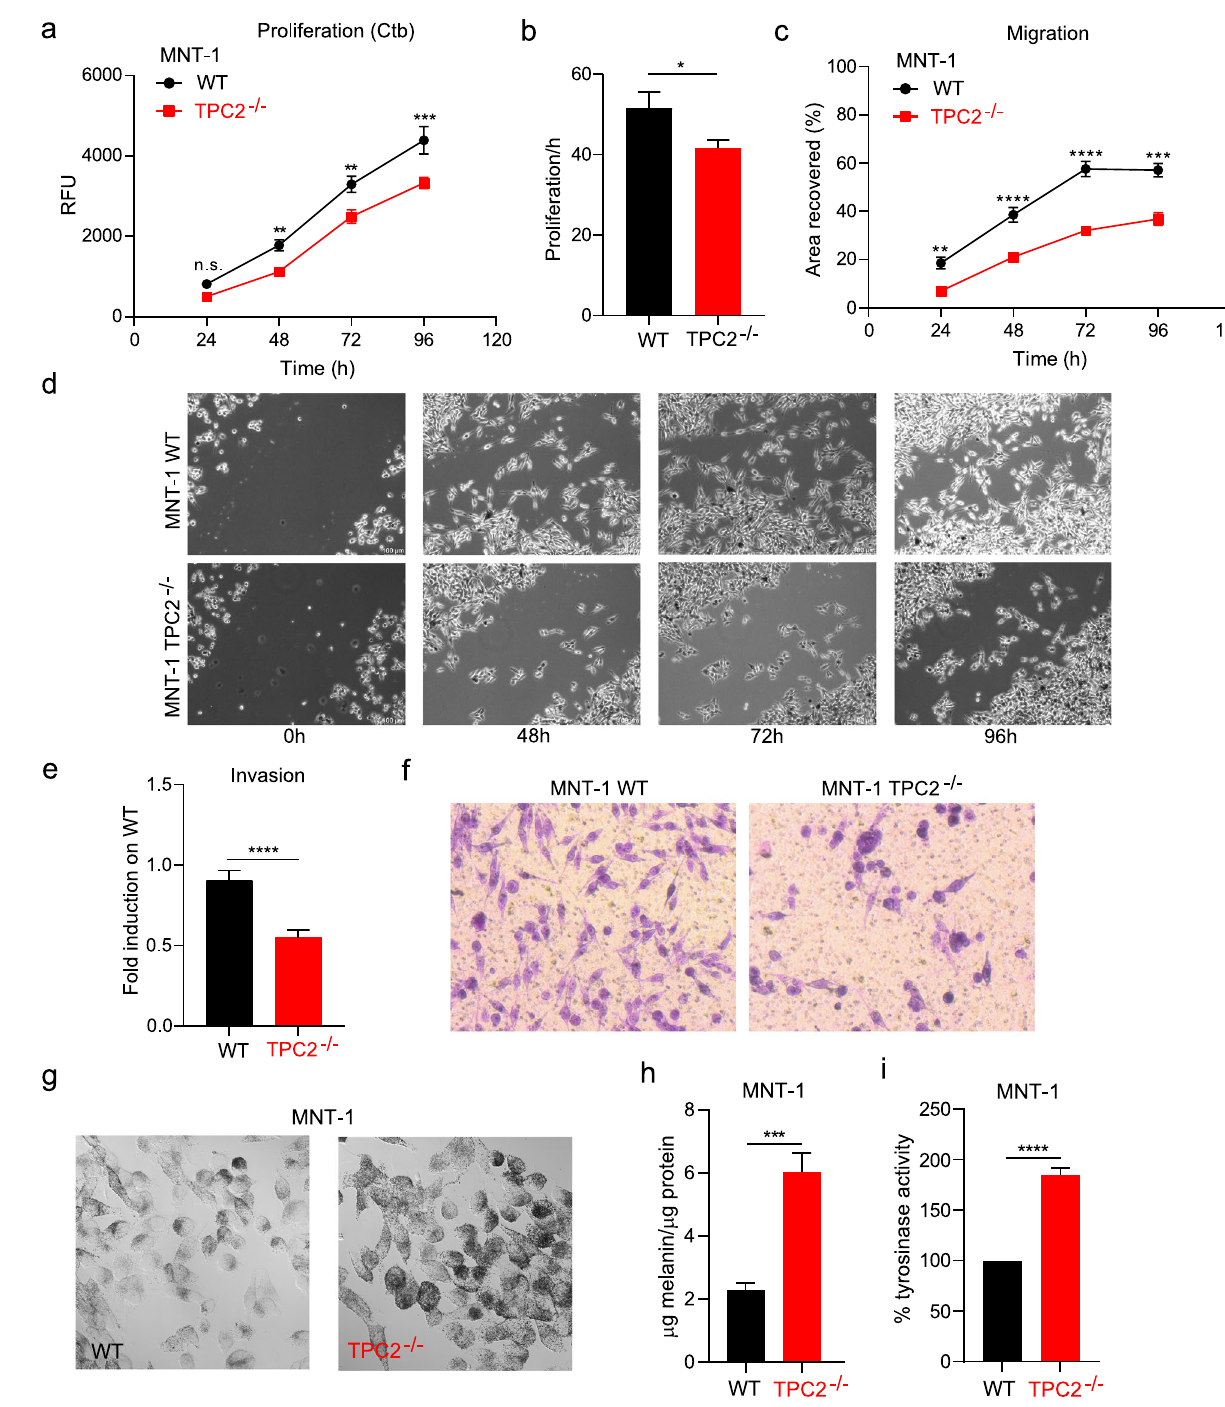
Figure 1. Proliferation, migration, and invasion in WT and TPC2 −/− MNT-1 cells. Proliferation was assessed using the CellTiter- Blue (Ctb) assay for the different time-points subtracted from the 0 h value reading of cells. Viable, metabolically active cells undergo a reduction reaction of resazurin to resorufin, while non-viable cells do not. Migration was assessed using the wound healing scratch assay, and invasion using transwell chambers in MNT-1 melanoma cells. ( a ) Genetic ablation of TPC2 in MNT-1 cells shows significant reduction of proliferation over 96 h. ( b ) Rate of proliferation per hour shows significant reduction in TPC2 −/− cells. ( c ) Migration in TPC2 −/− cells is significantly slower compared to WT MNT-1 cells, monitored for 24, 48, 72, and 96 h. ( d ) Representative images of wound healing monitored in WT and TPC2 −/− cells at different time-points. ( e ) and ( f ), MNT-1 TPC2 −/− are significantly less invasive than WT cells after 24 h. Statistical analysis ( e ) and representative Figures of WT and TPC2 −/− MNT-1 cells are shown ( f ). Cells were allowed to migrate into transwell chambers for 24 h. ( g ) Laser scanning microscope images visualizing the differences between WT and TPC2 −/− MNT1 cells in melanin content. ( h ) Quantification of melanin content in WT and TPC2 −/− MNT1 cells normalized to total protein content. ( i ) Tyrosinase activity was determined by the rate of dopachrome formation. The activity was expressed as percentage of WT cells. Statistical significance was determined by either two-way ANOVA followed by Bonferroni multiple comparisons test ( a , c ) or Student’s t-test ( b , e , h , i ). Shown are mean values ± SEM, (n = 3, each). *P < 0.05, **P < 0.01, ***P < 0.001, ****P <